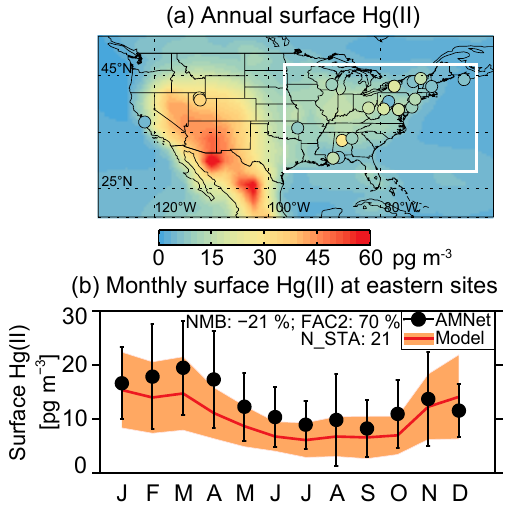
Figure 3. (a) Annual surface Hg(II) concentrations over the US. The map backgrounds show the GEOS-Chem concentrations (2013–2014), and the filled circles show the observations at Atmo- spheric Mercury Network (AMNet) sites (2009–2012). (b) Monthly surface Hg(II) concentrations at the AMNet sites in the eastern US (white box in panel a ). Black circles and error bars show the mean and standard deviation of the monthly-mean observations. Red lines and orange shading indicate the modeled means and standard devi-